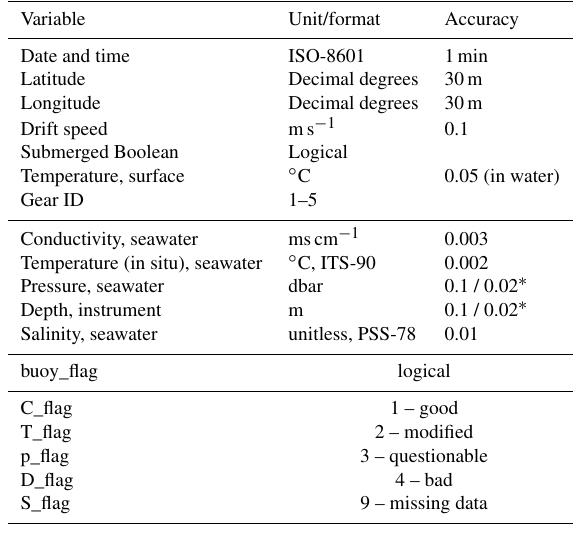
Table 2. Variables of the processed dataset. The nominal depths of the five CTDs (represented by gear IDs 1–5) were 10, 20, 50, 75, and 100m. The actual depths are given by the depth